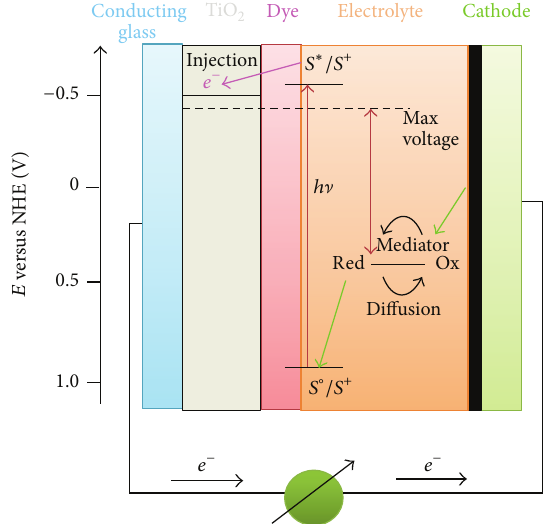
Figure 1: Structure and working principle of DSSC, with 𝑆 ∘ /𝑆 + /𝑆 ∗